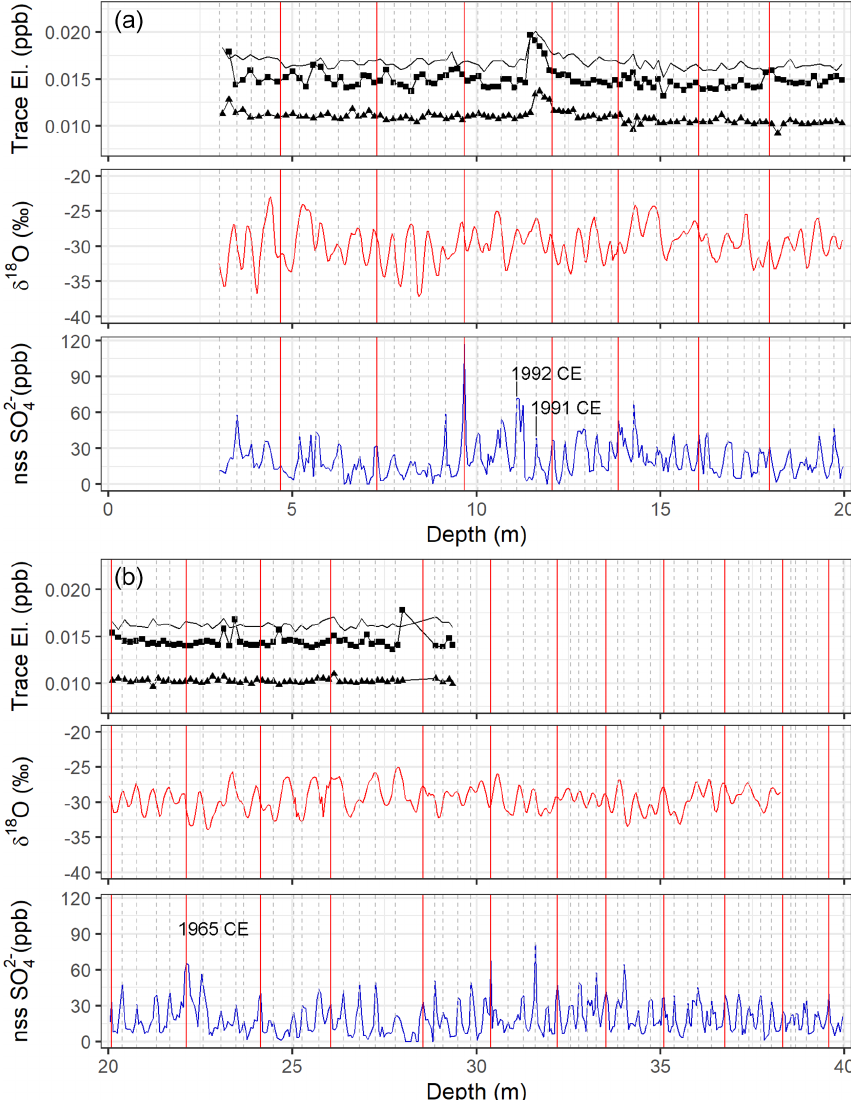
Figure 2. Concentration profiles of trace elements ( 205 Tl, solid black line, 209 Bi, black squares, 238 U, black triangles), δ 18 O (red line) and nssSO 2 − (blue line) along the uppermost 20m (a) and 20–40m intervals (b) of the GV7 (B) core. Vertical dashed gray lines and red 4 lines mark annual and 5-year intervals, respectively. The Agung and Pinatubo/Cerro Hudson volcanic signatures are also highlighted in the nssSO 2 − profile with their deposition 4